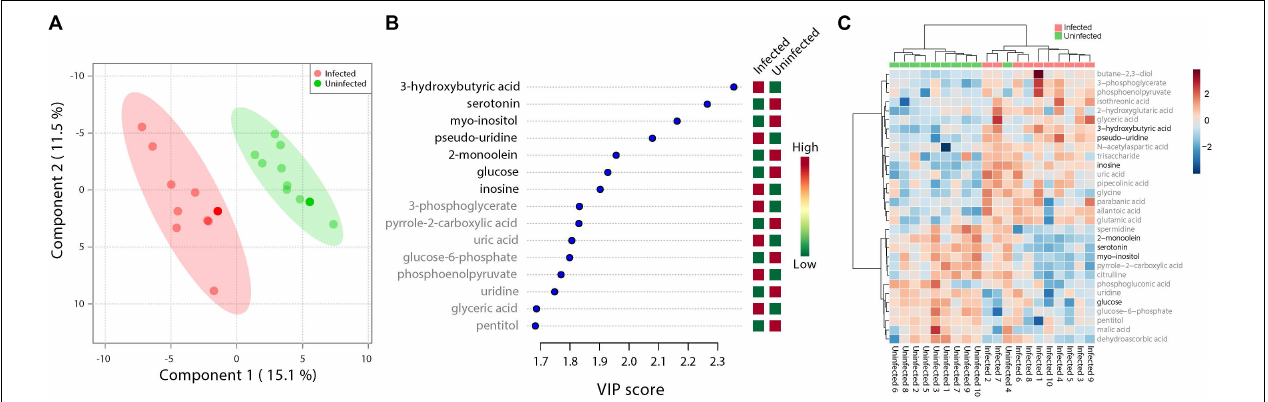
FIGURE 1 | Fluctuations in levels of primary metabolites following ZIKV infection of mosquito whole bodies. ZIKV infection is associated with alterations in primary metabolites abundance. (A) Multivariate comparative analysis performed using partial least squares discriminant analysis (PLS-DA) component biplot revealed a distinct clustering of primary metabolites according to the infection status of the individual source. (B) Variable Importance in Projection (VIP) score, a measure of a metabolites’ importance in the model is reported for each of the top 15 metabolites. This measure is calculated by removing the relationship of a metabolite and measuring increase in error. The metabolite with highest VIP score is considered to have the highest association with the infectious state. The X axis indicates the VIP scores corresponding to each variable on the Y axis. Red boxes indicate metabolites increased abundance in infected replicates while green indicates decreased abundance. The metabolites represented in black fonts represent that which were statistically significant by t -test (FDR < 0.05). (C) Heatmap plot was generated on the MetaboAnalyst program using hierarchical, agglomerative cluster analysis. The distance measure was Euclidean (Motzkin, 1949) and the clustering algorithm utilized was Ward (Ward and Hook, 1963). The t -tests were performed with a cut off of an FDR adjusted p -value of 0.05. The X axis represents the individuals with the corresponding infection status while the Y axis represents the compounds identified with the statistically significant (FDR < 0.05) compounds represented in black. The heat map shows the level of intensity of abundance of each compound across each individual. Red coloration represents increased abundance while blue coloration represents decreased abundance in relation to infection state.